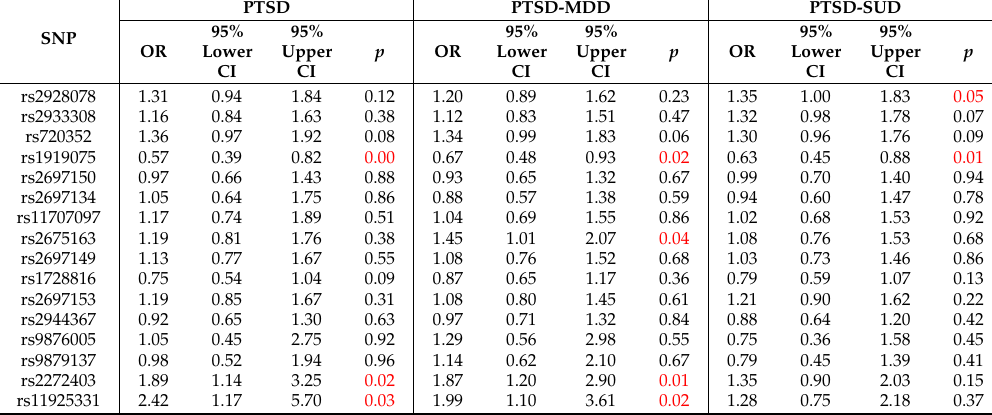
Table A1. The effect of each SNP on the risk of PTSD (i.e., individuals with only Posttraumatic Stress Disorder), PTSD-MDD (i.e., comorbid Posttraumatic Stress Disorder and Major Depressive Disorder), and PTSD-SUD (i.e., comorbid Posttraumatic Stress Disorder and Substance Use Disorder) in Caucasians, adjusting for age, sex and CES.